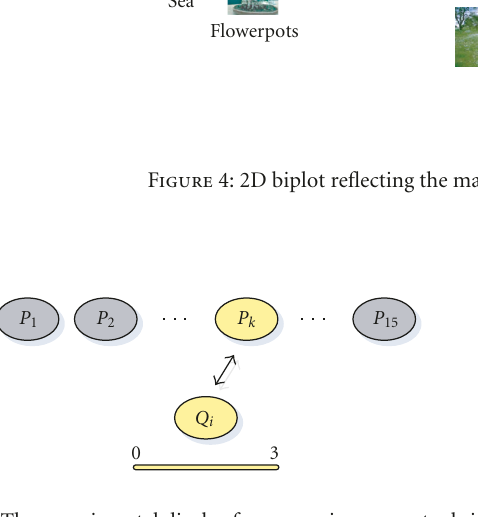
Figure 5: The experimental display for expressing perceptual simi- larity between a query image Q i and the set of class prototypes P k